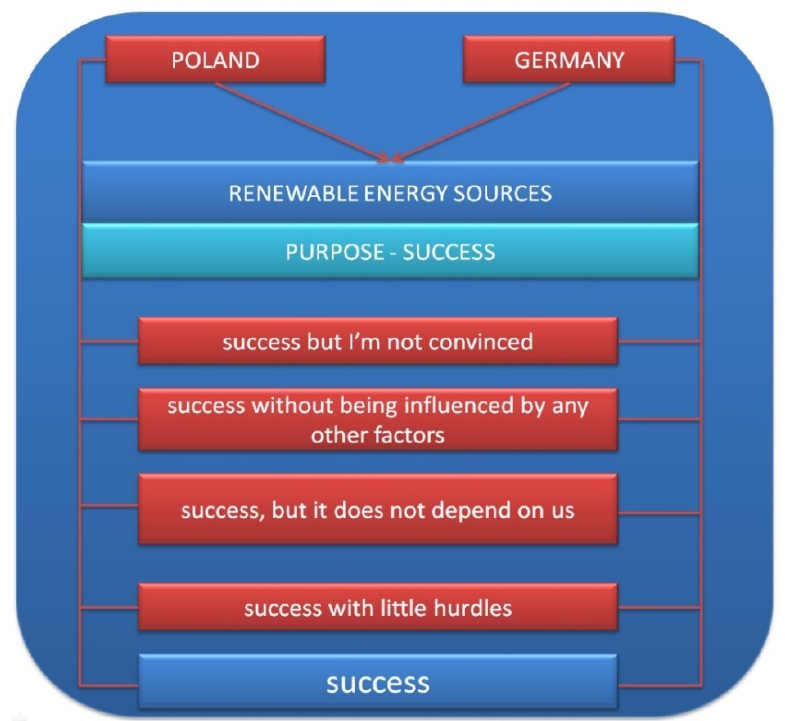
Figure 19. Accepted Success Opportunities.